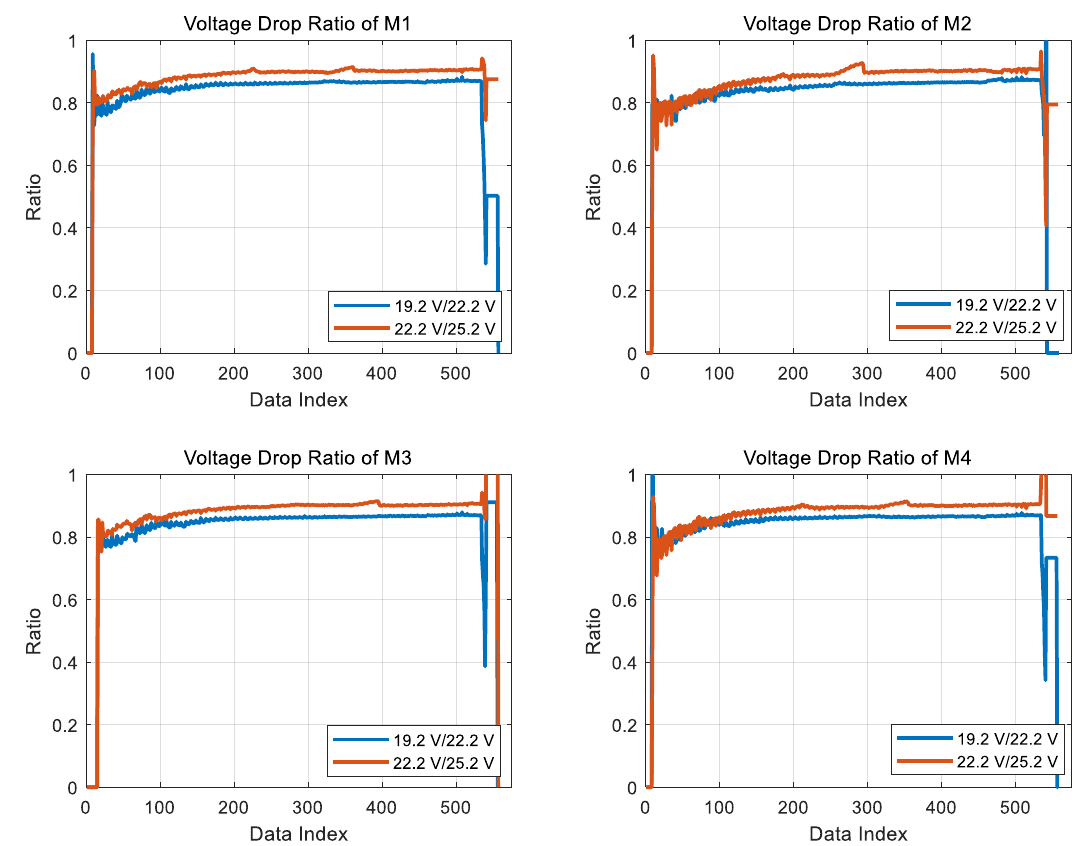
Figure 13. Ratio of Mx RPM (22.2 V) to Mx RPM (25.2 V) and Mx RPM (19.2 V) to Mx RPM (22.2 V).